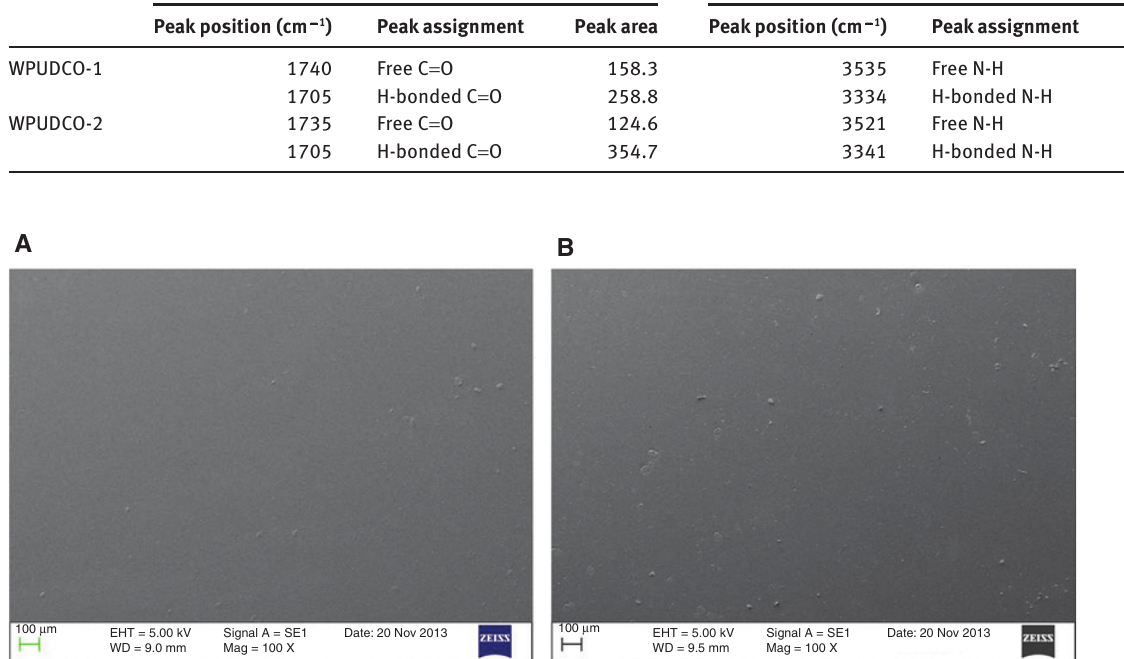
Table 3: Fourier transform-infrared (FT-IR) deconvolution results of C = O and N-H zone for polyurethane (PU)-prepolymer. Sample C = O zone